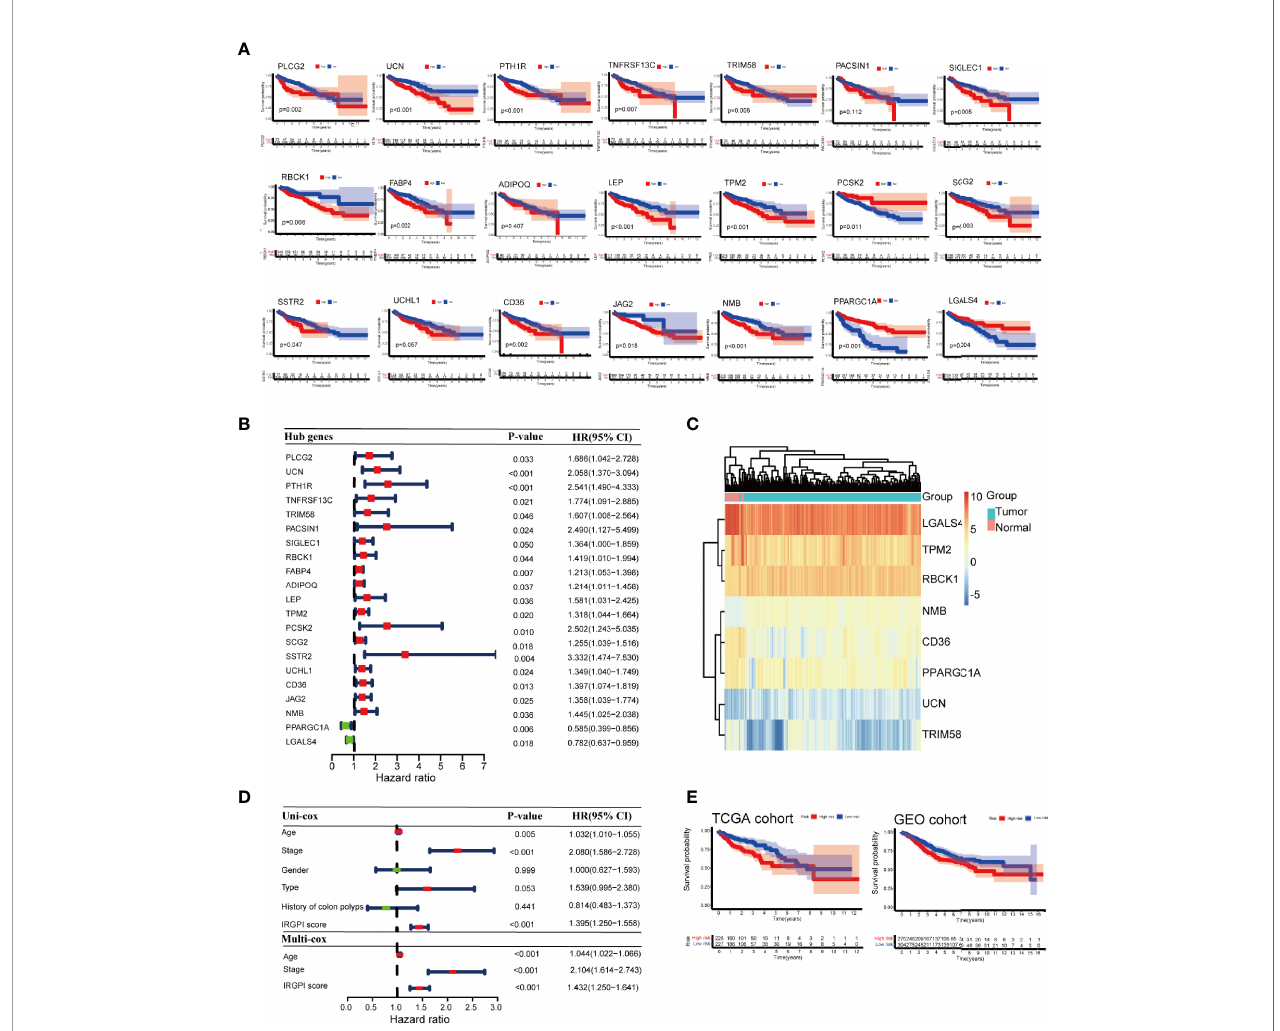
FIGURE 4 | Prognostic analysis of different colon cancer groups. (A) Kaplan-Meier survival analysis of the 21 immune-related hub genes. (B) Univariate Cox analysis of 21 immune-related hub genes. (C) Heat map of 8 genes in IRGPI score. (D) Univariate Cox analysis of clinicopathological factors and IRGPI scores, and multivariate Cox analysis of factors signi fi cant in univariate Cox analysis ( P < 0.05). (E) Kaplan-Meier survival analysis of IRGPI groups in the TCGA cohort and the GEO cohort. IRGPI, immune-related gene prognostic index; TCGA, The Cancer Genome Atlas; and GEO, Gene Expression